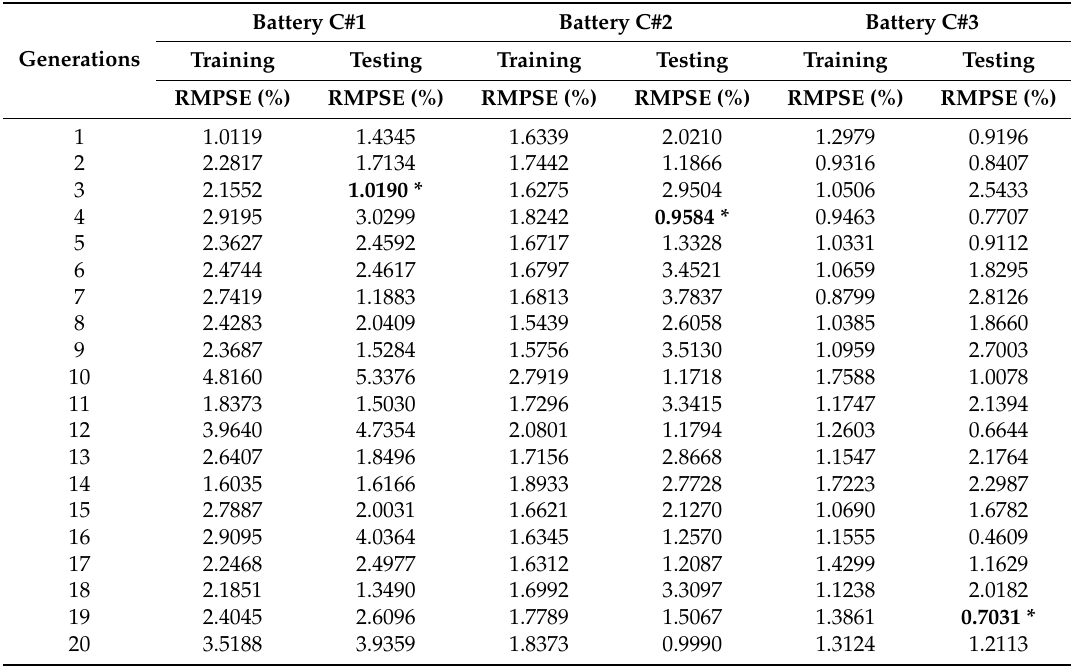
Table 2. Summary of the difference between the MPF-estimated charge capacities at the GA generations with the experimental data, as measured with the root mean square percentage error (RMSPE) at the 80:20